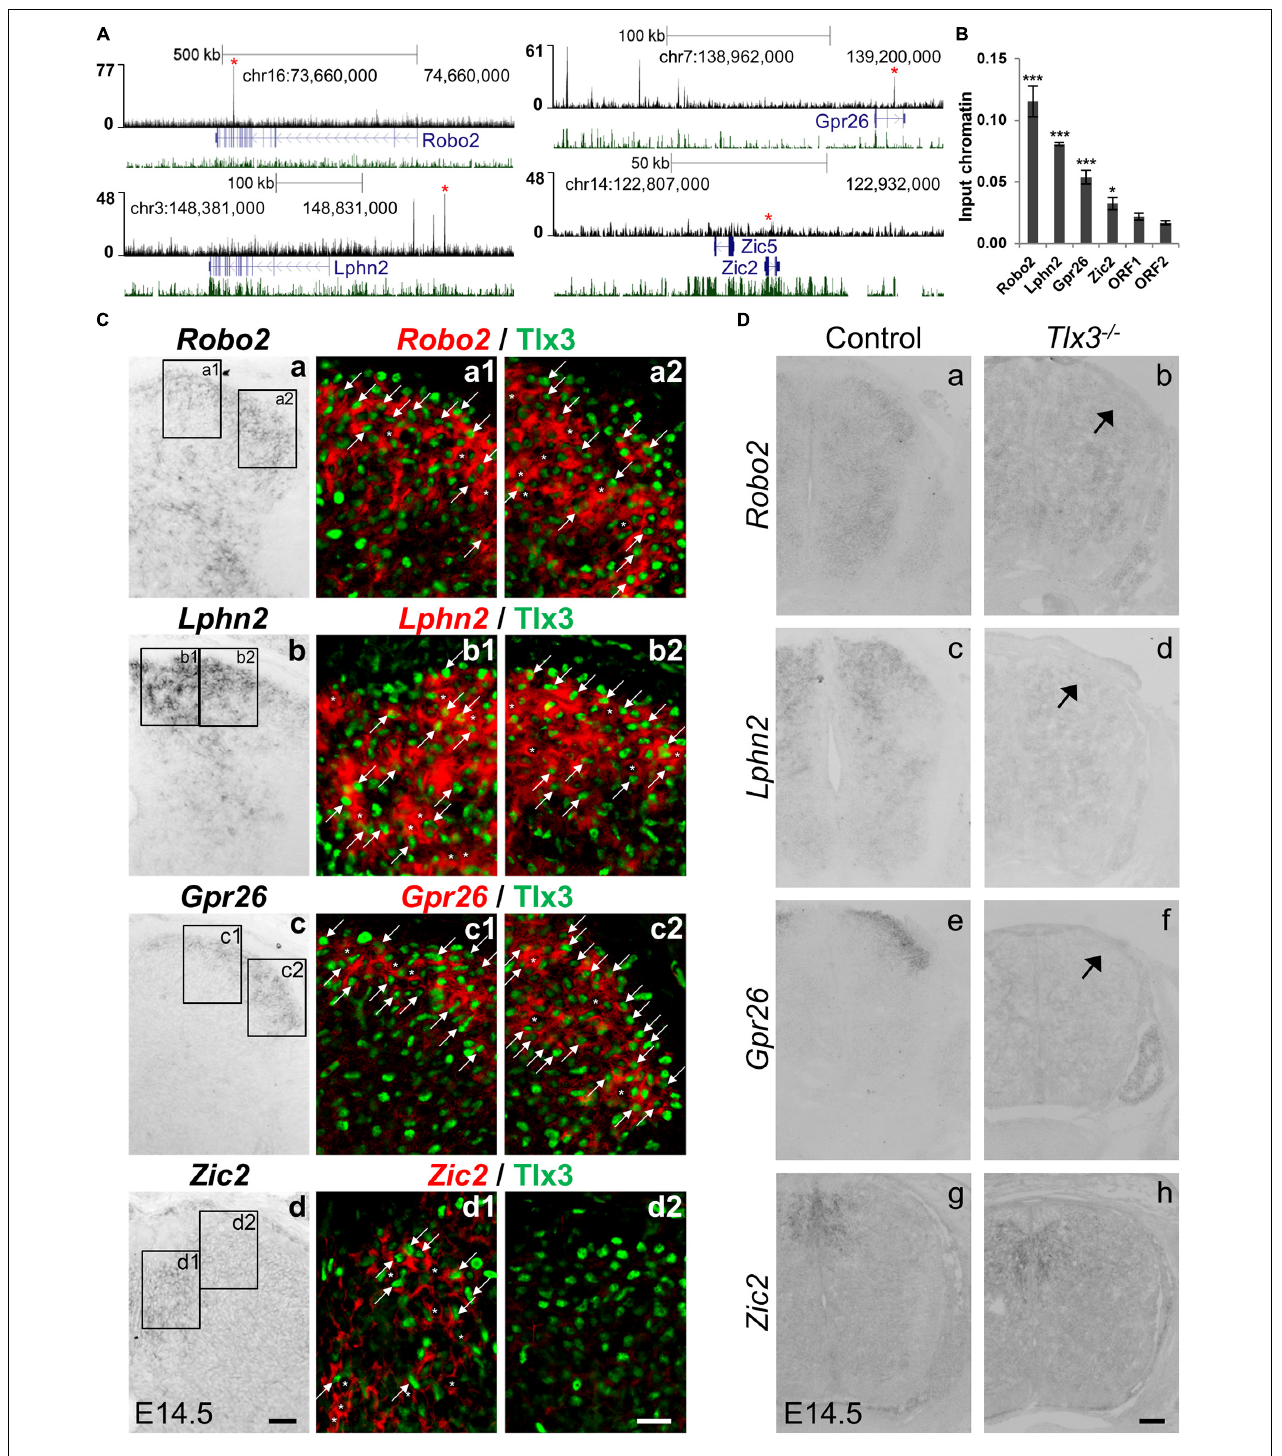
FIGURE 3 | Identification of novel Tlx3 target genes. (A) Tlx3 binding profile (black) within genomic regions spanning target genes. Target gene structure and direction of transcription (blue) as well as multispecies vertebrate conservation plot (green) are shown. Binding sites used for ChIP-qPCR validation are marked by red asterisks. (B) Validation of Tlx3 binding sites by independent ChIP-qPCR using chromatin extracted from E14.5 dorsal spinal cords. Two negative control regions (ORF1/2) are shown. Mean ± SD; * P < 0.05 and *** P < 0.001 as compared to ORF1 with Student’s t -test; n = 3 experimental replicates. (C) Expression of Robo2 , Lphn2 , Gpr26 , and Zic2 in Tlx3 + neurons. a–d In situ hybridizations using transverse sections of lumbar spinal cord of E14.5 wild type embryos. a1–d2 Double staining of Tlx3 protein (a1–2, b1–2, c1–2, d1–2, green) with either Robo2 (a1–2, red), Lphn2 (b1–2, red), Gpr26 (c1–2, red), and Zic2 (d1–2, red)